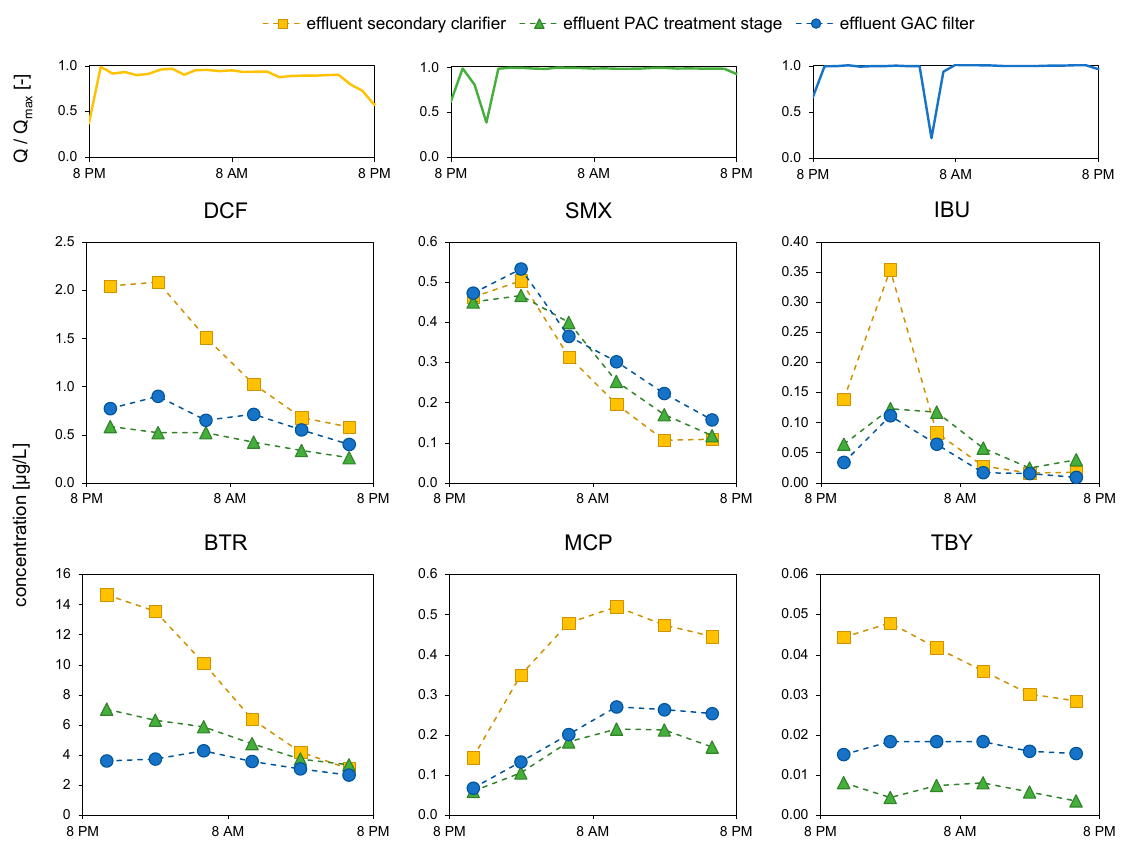
Figure 5. Q/Q max and concentrations over time for the three sampling points during the rain event WW2 for several OMPs.